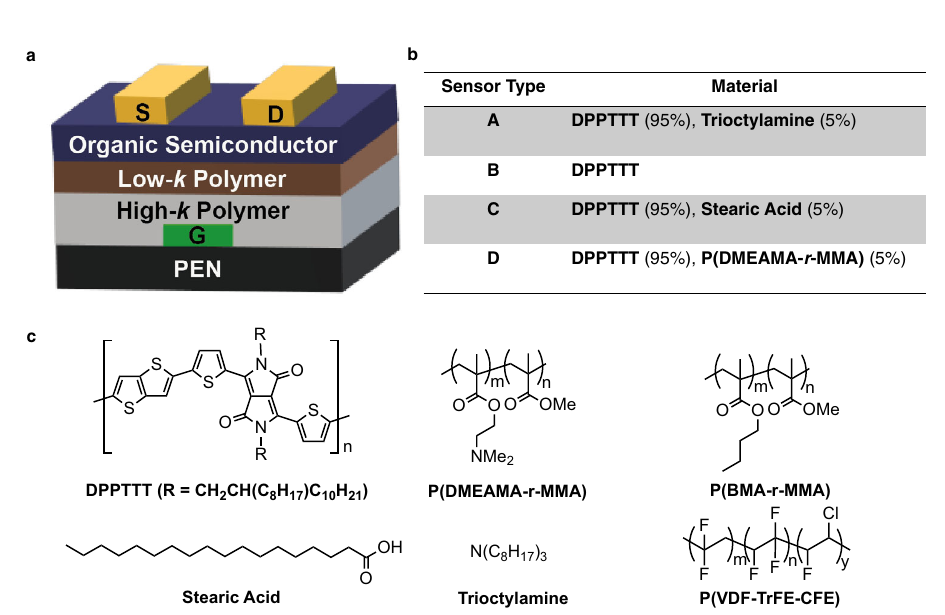
Fig. 2 | OFET devices as VOC sensors. a Schematic of bottom gate, top contact OFET used in this work (S, D, and G are source, drain, and gate electrodes, respectively). b Compositionsoftheorganicsemiconductorlayersusedinthefour